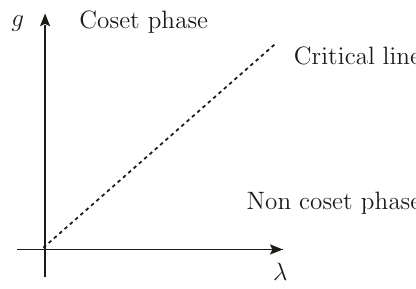
Figure 4 . Sketch of phase diagram compatible with scenario iii). There is a critical line with a gap closing separating two distinct topological